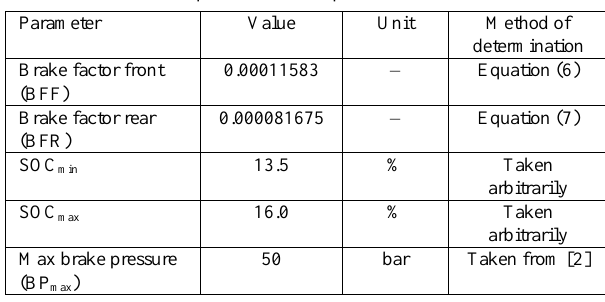
Table 4. Examples of values of parameters and constants Parameter Unit Method of